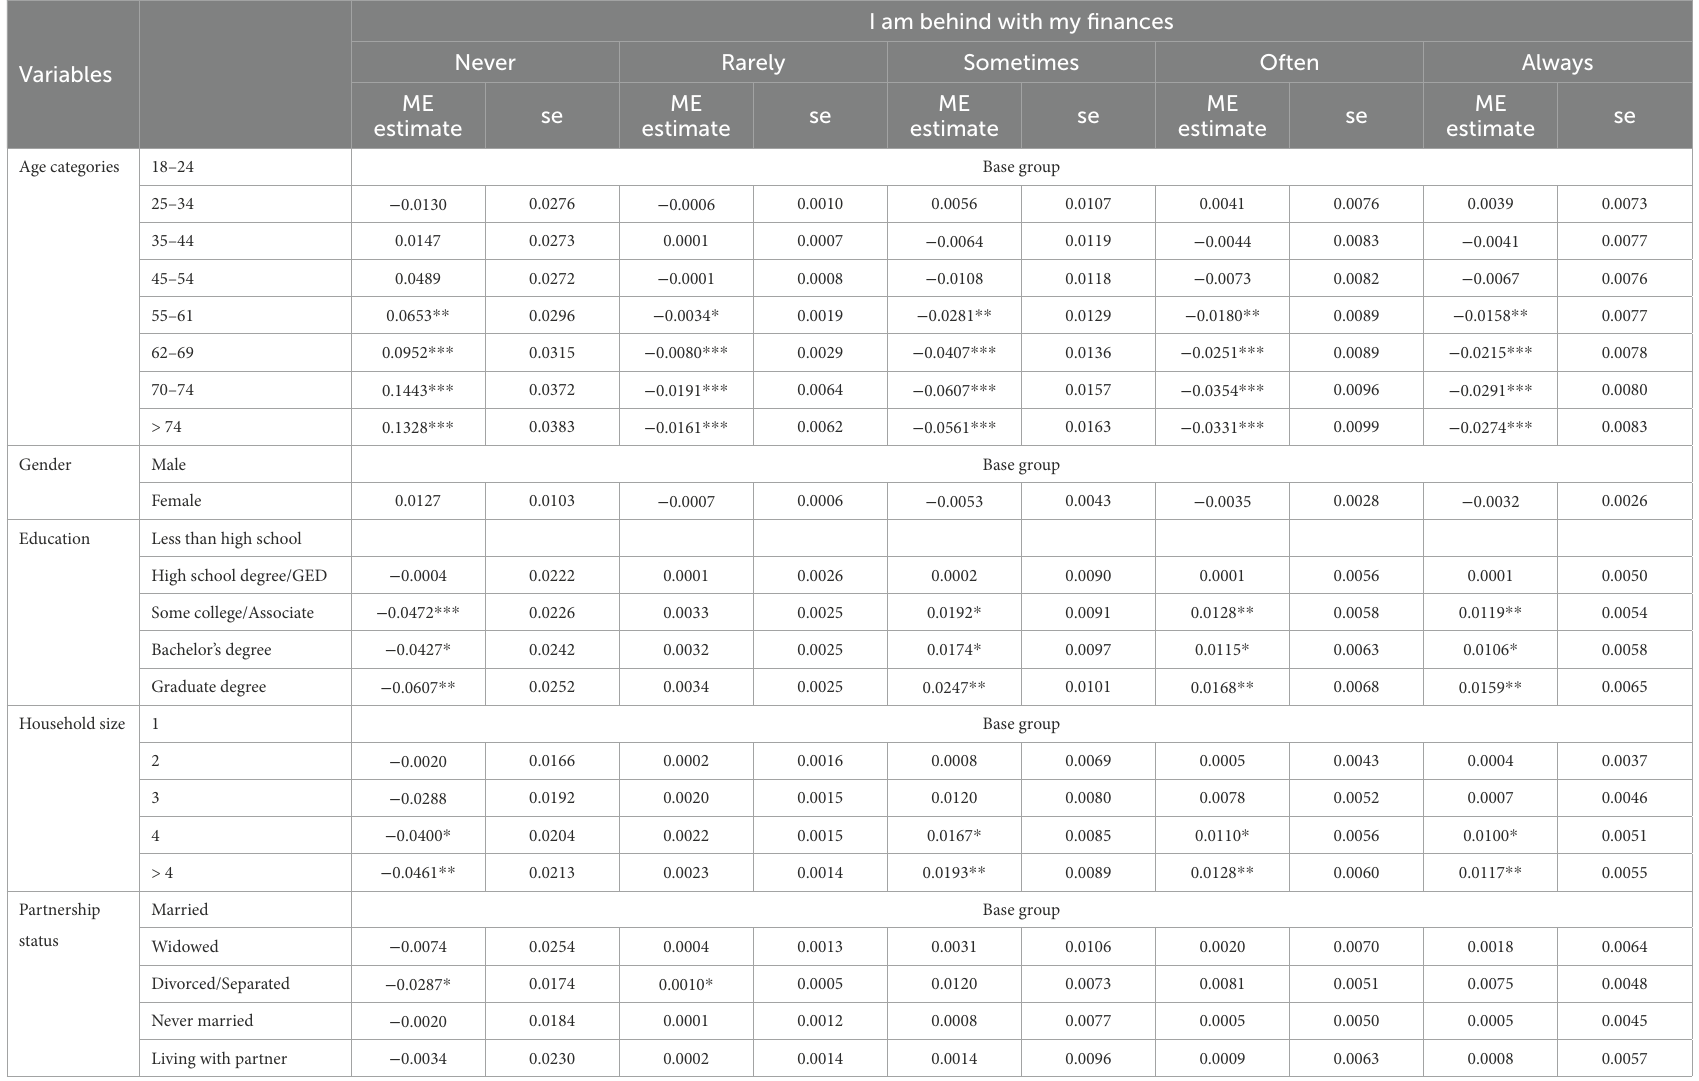
TABLE 3 Ordered logit marginal effect (me)